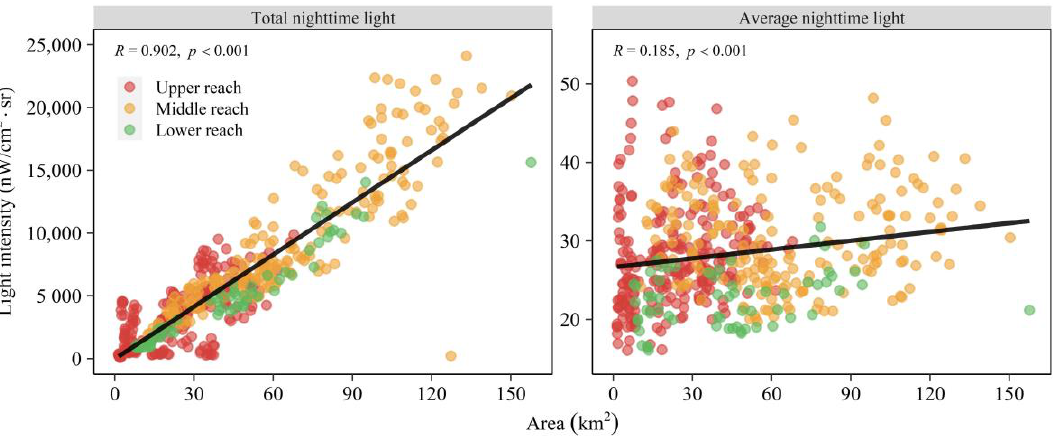
Figure 6. Correlation analysis of average nighttime light intensity (ANTL) and total nighttime light intensity (TNTL) and the built-up area in the upper, middle, and lower reaches of the Yellow River